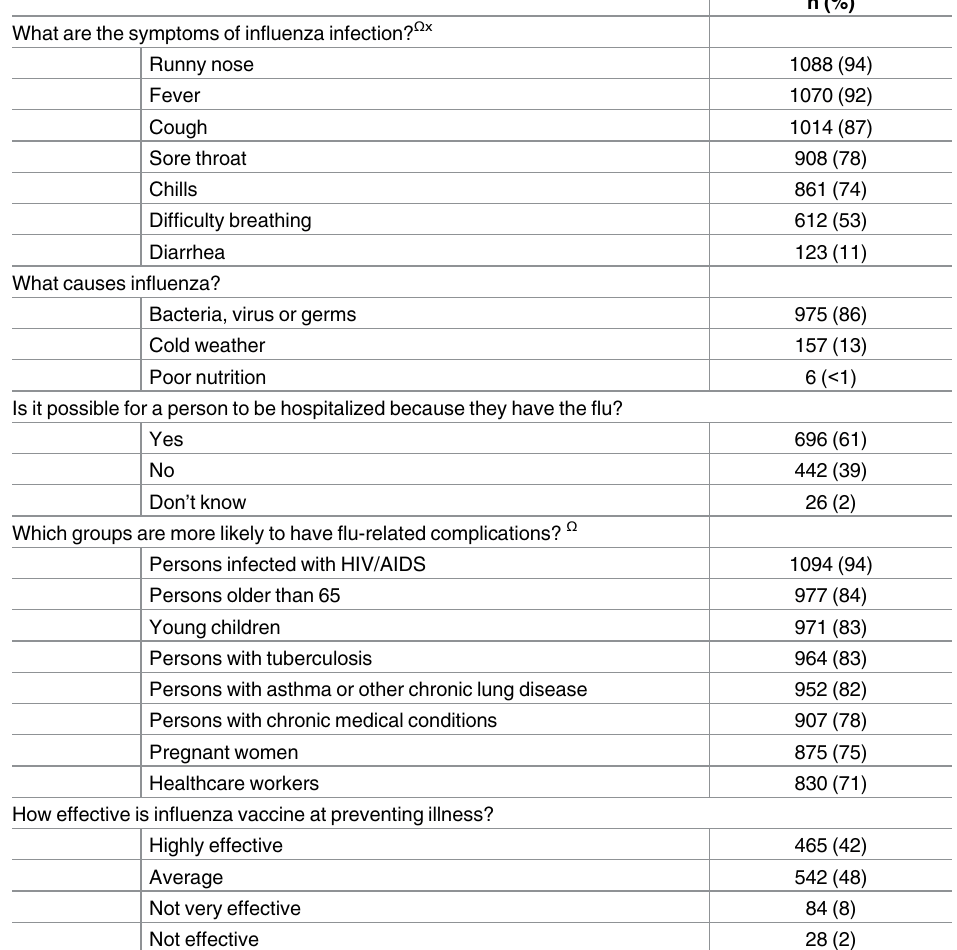
Table 2. Knowledge and attitudes of South African healthcare workers regarding influenza infection and vaccination (N = 1164) ** . What are the symptoms of influenza infection? Ω